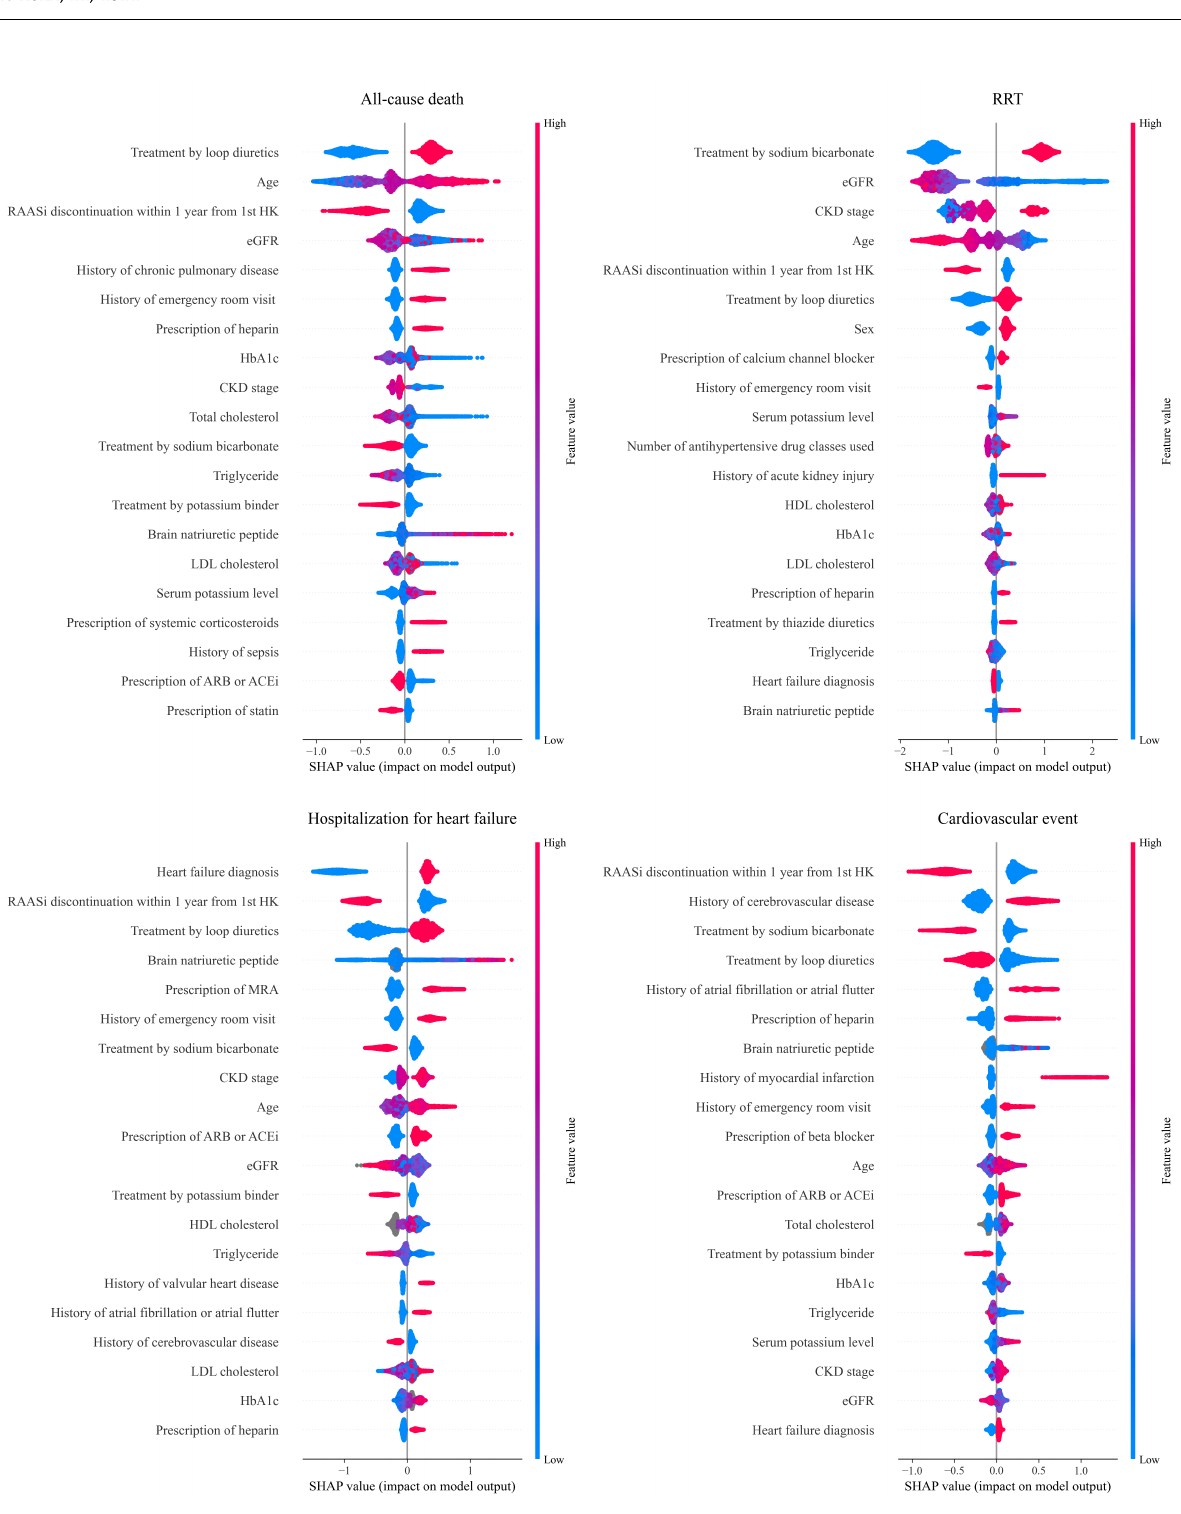
Figure 3. Shapley additive explanations summary plots of the top 20 most important variables for Figure 1. This is a figure. Schemes follow the same formatting. If there are multiple panels, they the extreme gradient boosting should be listed as: ( a ) Description of what is contained in the first panel. ( b ) Description of what is contained in the second panel. Figures should be placed in the main text near to the first time they are cited. A caption on a single line should be centered.